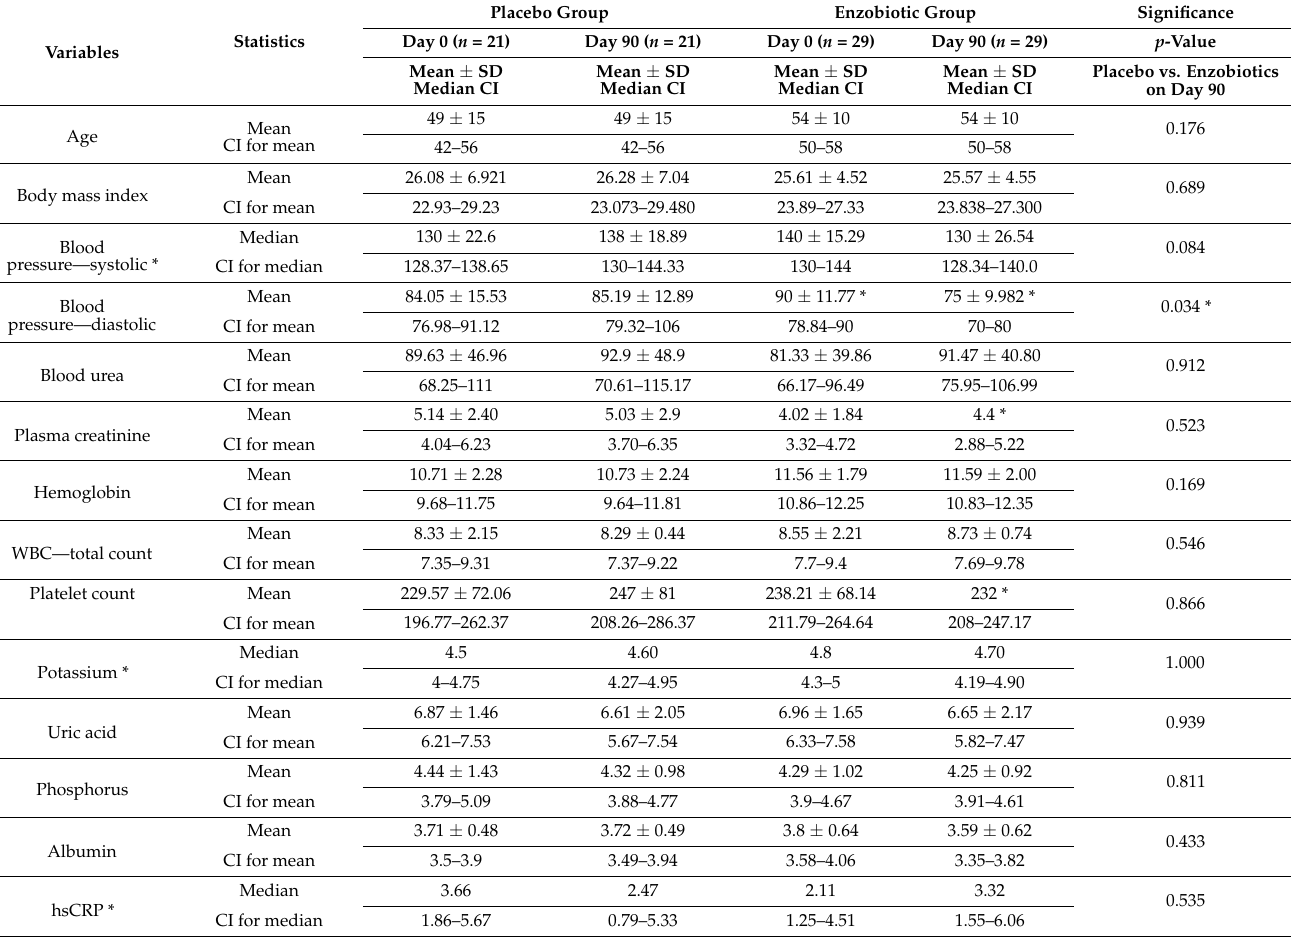
Table 2. Baseline demographics and lab